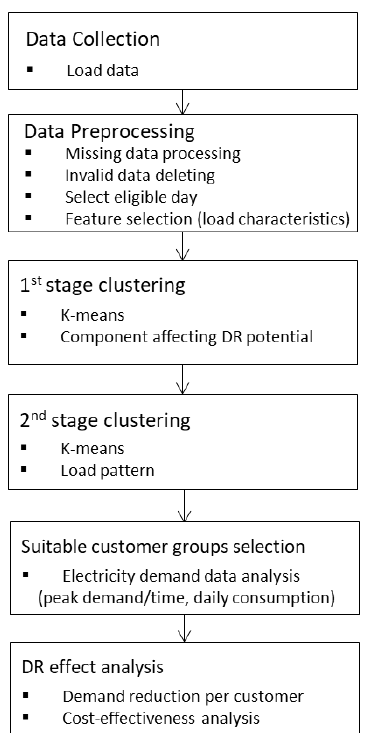
Figure 1. Flowchart of the proposed two-stage clustering methodology and customer targeting strategy.